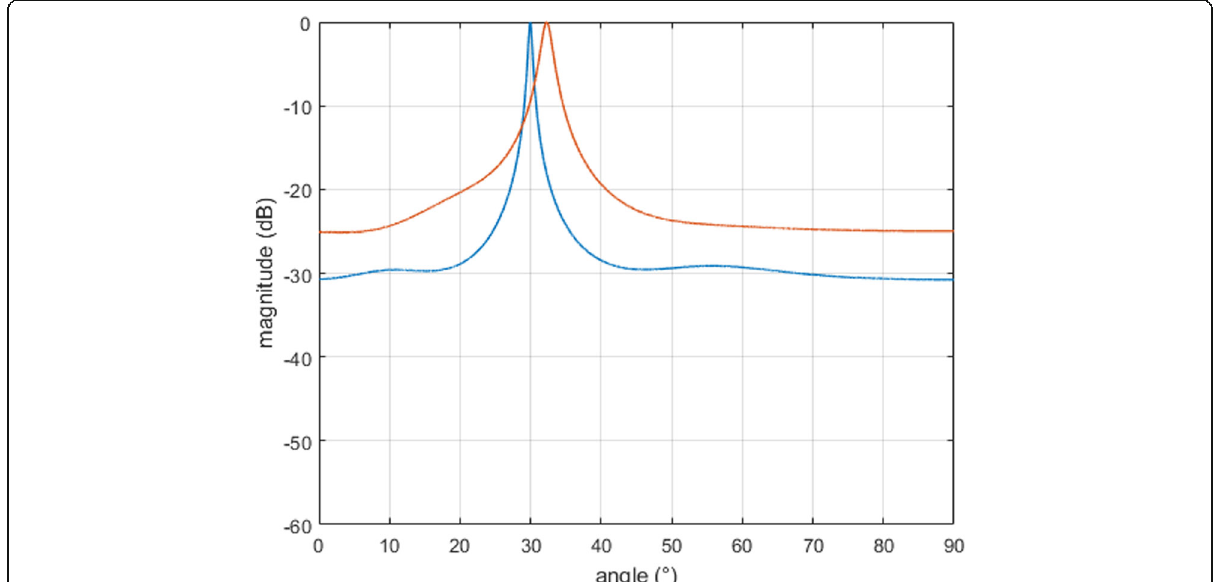
512, and 1024, respectively. From Fig. 8, the increase in the number of snapshots reduces the RMSE of DOA es- timation. Then, the increase in that will also increase the calculation time. The impact of a small user-defined positive scalar ε on RMSE is also simulated. With the 512 snapshots, ε is 0.3, 0.5, and 0.7, respectively. From